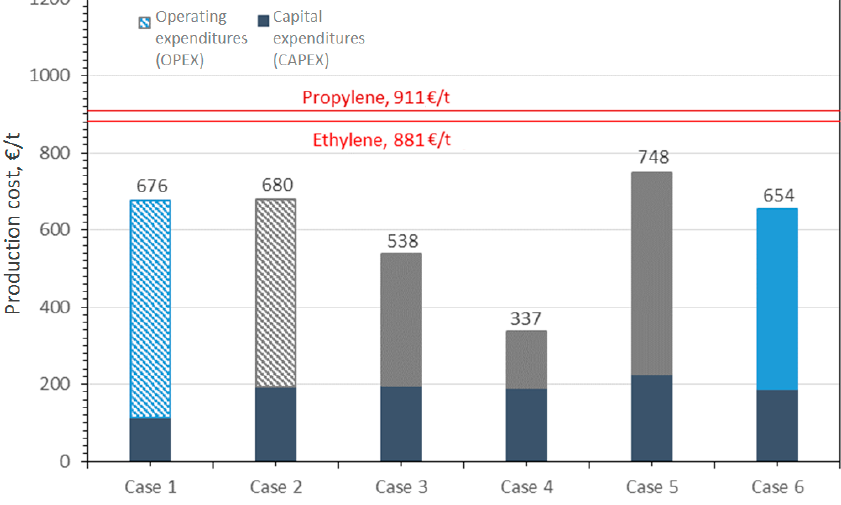
Figure 15. Production cost of olefins (2030/2050).